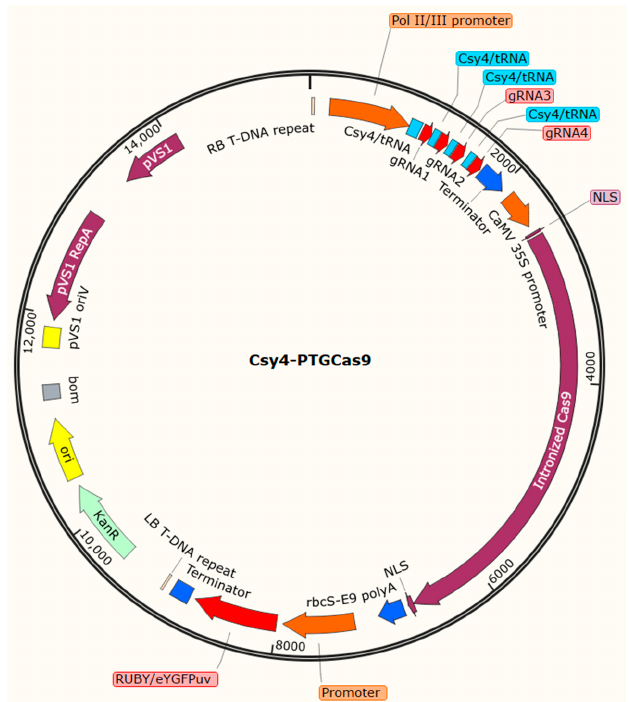
Figure 3. Schematic representation of an ideal vector with Csy4-gRNA/tRNA-gRNA processing sys- tems and TCTU configuration of gRNA and Cas9 cassettes for multiplexed “in root” gene functional analysis of soybean using CRISPR/Cas9-hairy root system.